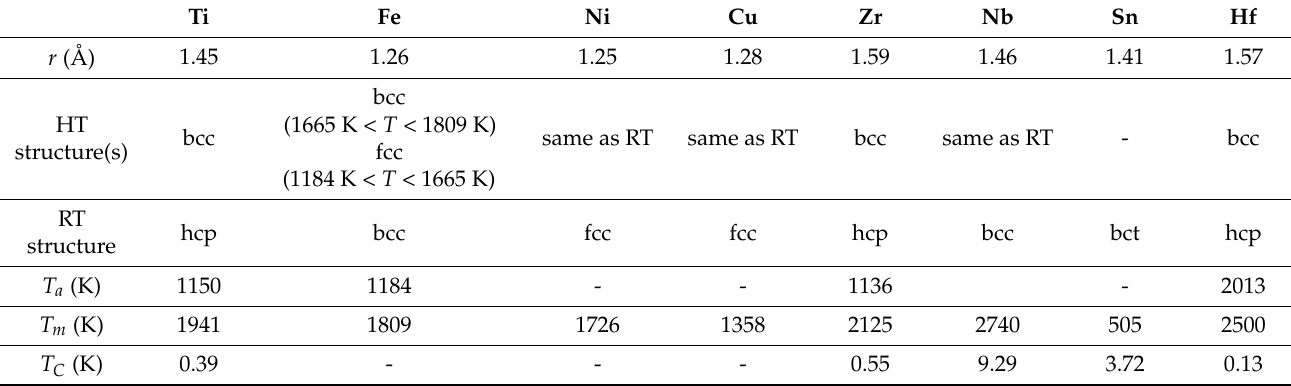
Table 1. Properties of the pure elements constituting the investigated alloys [6] (the atomic radius r , the type of high- temperature (HT) and room-temperature (RT) structure, the temperature T a of the allotropic transformation to the RT structure, the melting temperature T m , and the superconducting transition temperature T C